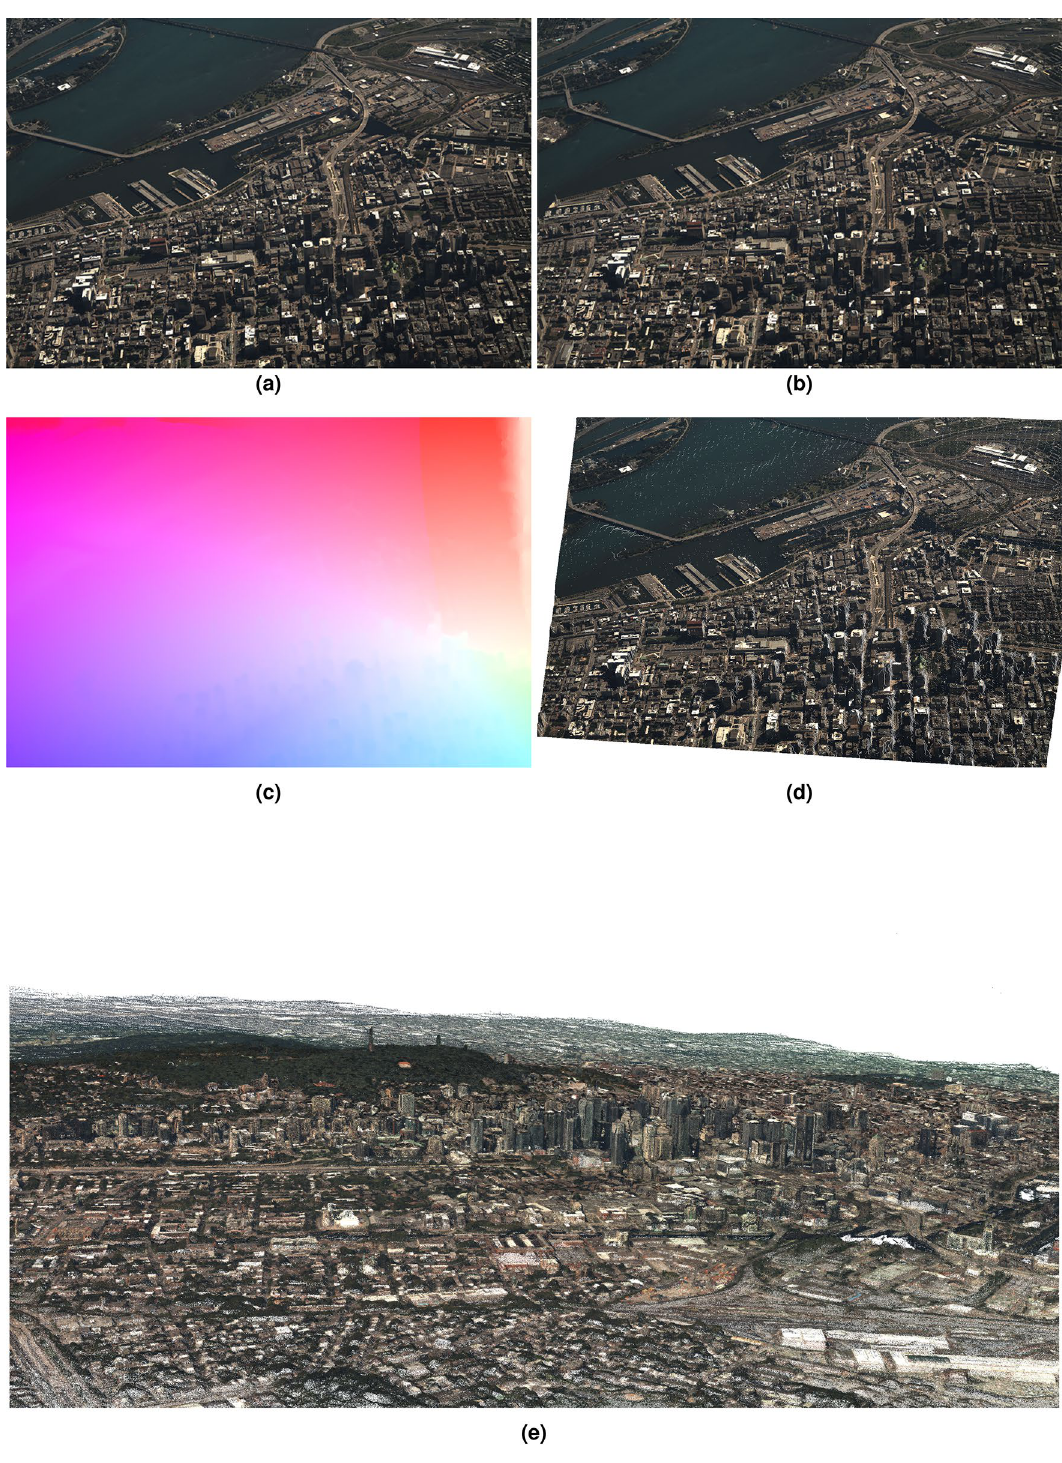
Figure 10. ( a,b ) Are two consecutive large-scale aerial images of a downtown urban area with resolution 6600 × 4400 , © His Majesty the King in Right of Canada, as represented by the Minister of National Defence, 2022. ( c ) HybridFlow is the only top-performing variational method that can handle high-resolution images. Deep learning techniques cannot be applied due to the fixed input size of the networks as explained in the text. ( d ) Image resampled from ( a ) using HybridFlow flows in ( c ) to form ( b ). ( e ) Reconstructed pointcloud using 320